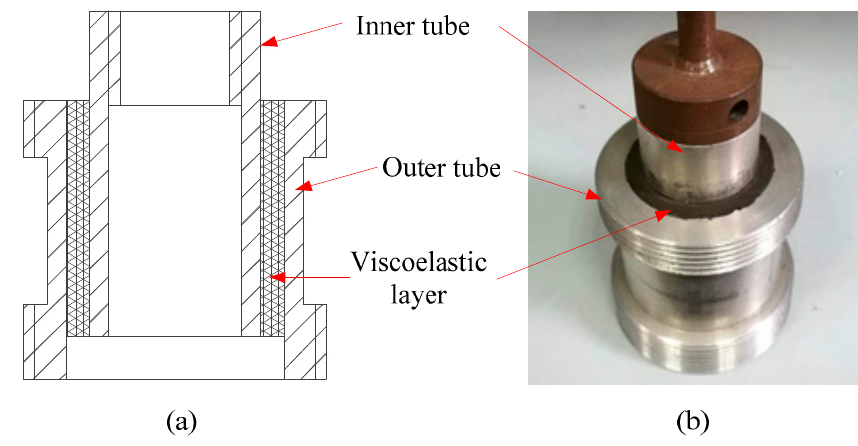
Figure 3. Cylindrical viscoelastic damper. ( a ) cross Section; ( b ) physical map.